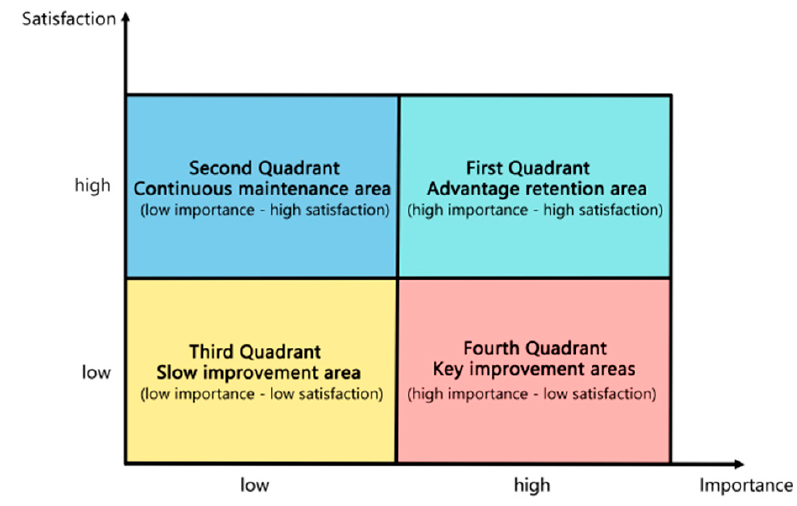
Figure 3. IPA quadrant diagram. Table 3. Evaluative indexes of tourist satisfaction with mountain landscapes in terms of recreation.